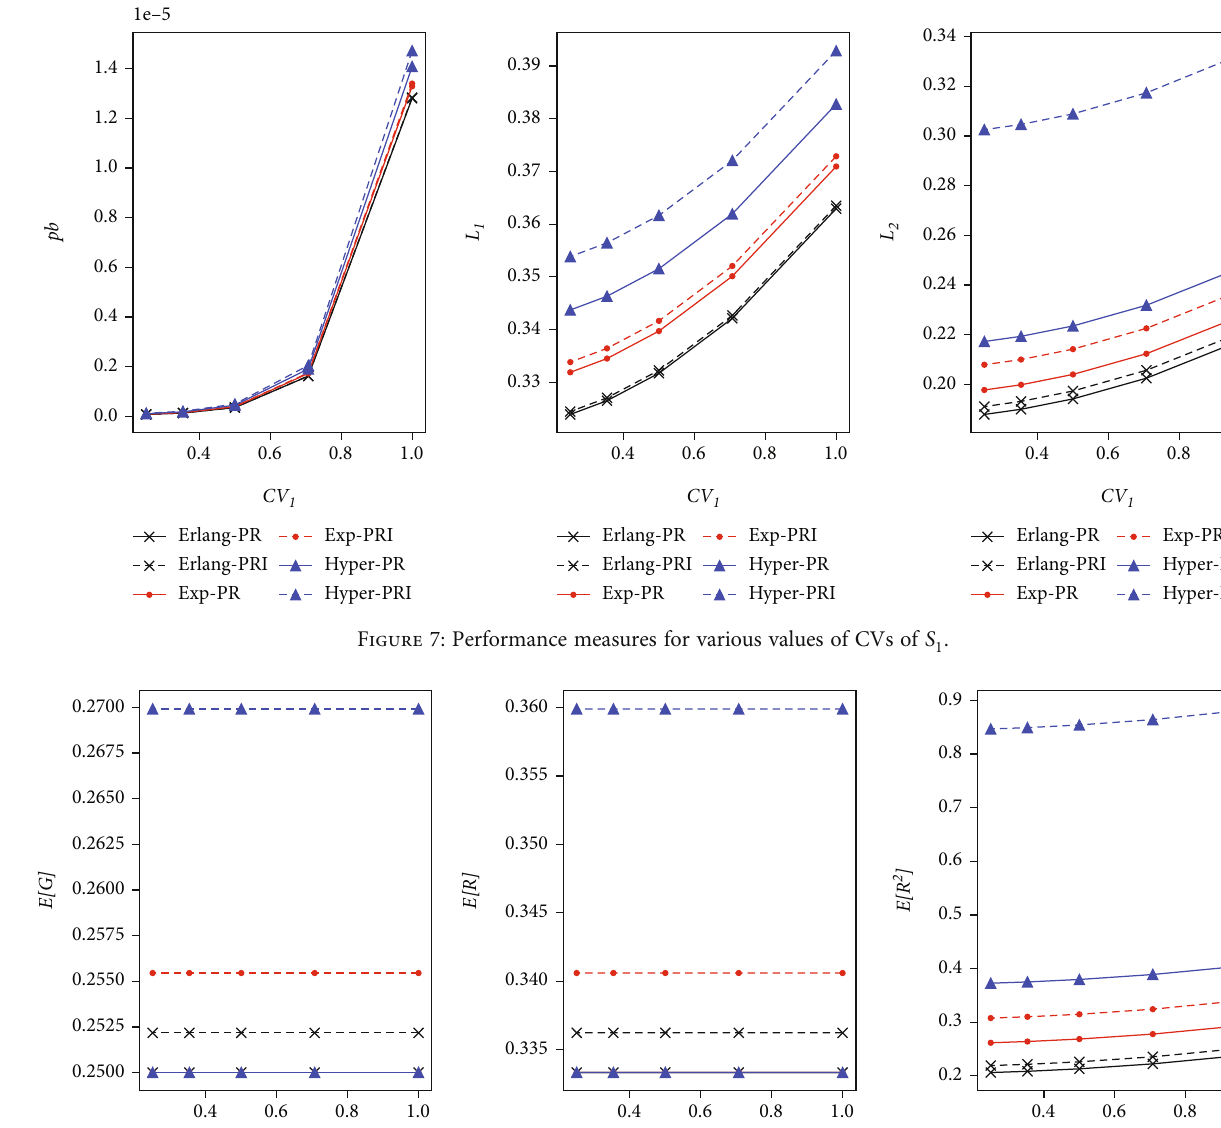
Figure 8: The expected gross service time and the fi rst and second moments of the occupation time of a class-2 customer for various values of CVs of S 1